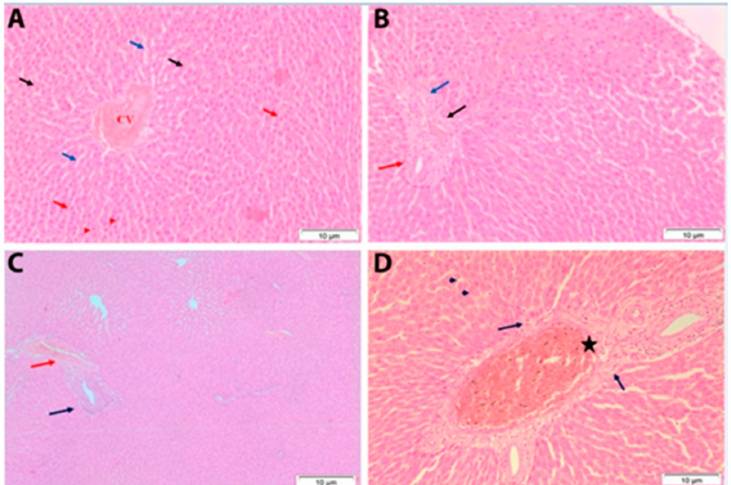
Figure 4. Histological analysis of the liver tissue in male rat exposed orally to 250 mg TiSiO 4 NPs/kg b.w. ( A , B ): control liver showing normal structure, ( A ): normal hepatic lobule. The central vein (CV) lies at the center of the lobule and intact with the hepatocytes (black arrows) with strongly eosinophilic granulated cytoplasm (red arrows), and distinct nuclei (arrow heads). In between the strands of hepatocytes, the hepatic sinusoids are shown (blue arrows); ( B ): normal structure of portal area surrounded with connective tissue and each portal area contains a branch of hepatic artery (black arrow), a branch of portal vein (red arrow), and a bile ductile (blue arrow); ( C ): male rat liver after 7 days post-administration showing congested portal area (red arrow) associated with necrosis (blue arrow) of the surrounding hepatocytes; ( D ): male rat liver after 28 days post-treatment showing congested portal area (asterisk) associated with necrosis of the surrounding hepatocytes (arrows) and the remaining hepatocytes displayed the normal structure (arrow heads). (H & E stain, Scale bar: 10 µ